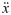
Plots of x¨ vs t (see Eq (18)) and z vs t (see Eq (20)) with parameter values λ/A = 0.7 and T = π/4.